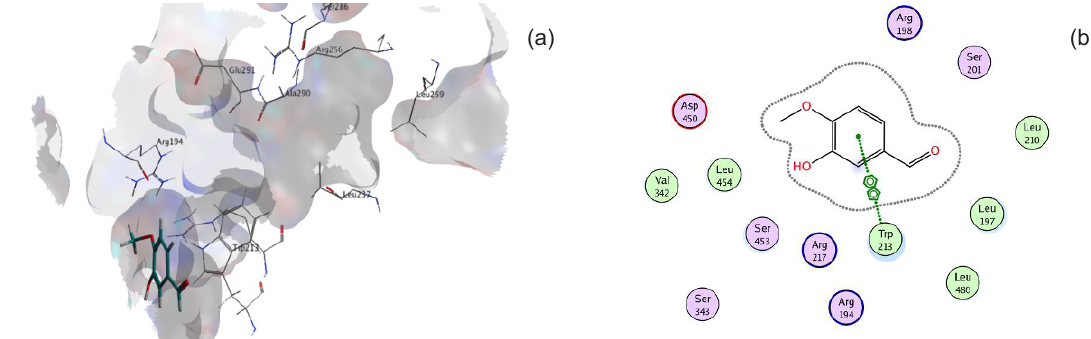
Figure 7. Molecular Docking model of interactions between the Bovine Serum Albumin (BSA) and isovanillin, generated by using Molecular Operating Environment (MOE) 2011.10. The BSA PDB file was taken from protein data bank (http://www.rcsb.org/pdb/explore. do?structureId=4F5S) (4F5S). The classical binding sites were marked in corresponding subdomain cations. See more details in the experimental section. Fig. 7 b representing a 2D scheme for interaction between the BSA binding sites and Isovanillin molecules. Where, the π - π interactions between the isovanillin and Trp213 residues of BSA binding sites are shown with green dashed